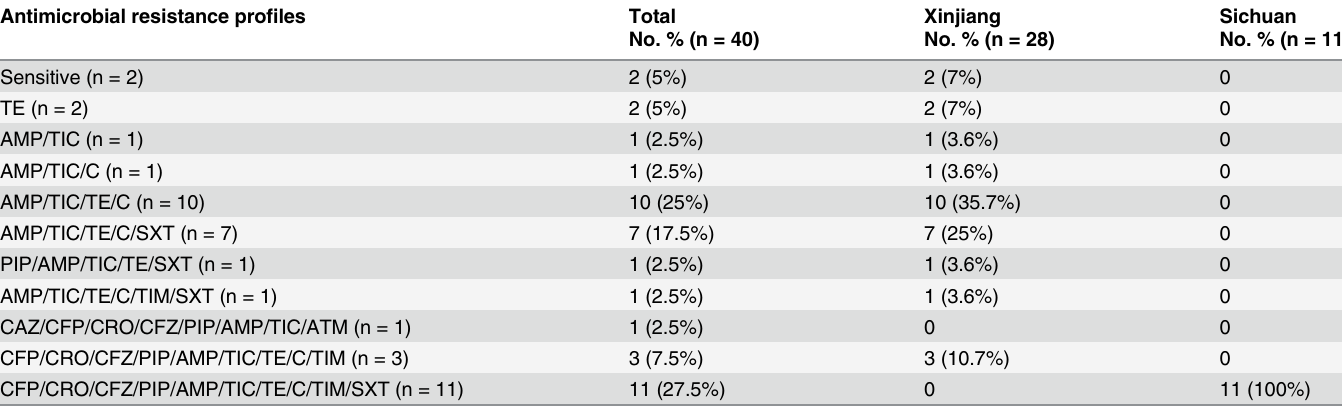
Table 5. Dominant antimicrobial resistance profiles of 40 S . flexneri 1b isolates from different regions of China. Antimicrobial resistance pro fi les